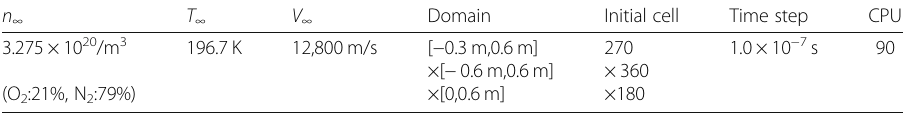
Table 5 Computational parameters for the case of Stardust at H = 80km for V ∞ = 12.8 k m/s n ∞